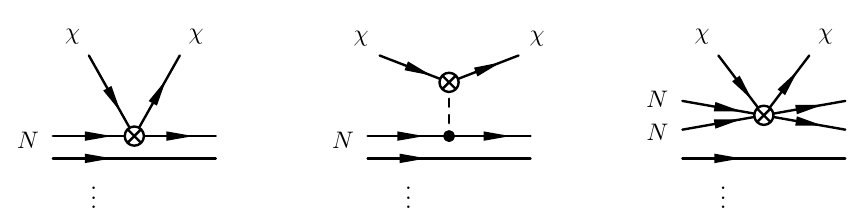
Figure 3 . The chirally leading diagrams for DM-nucleus scattering (the (cid:12)rst and second diagrams), and a representative diagram for two-nucleon scattering (the third diagram). The e(cid:11)ective DM- nucleon and DM-meson interactions are denoted by a circle, the dashed line denotes a pion, and the dots represent the remaining A 2 nucleon (cid:0)